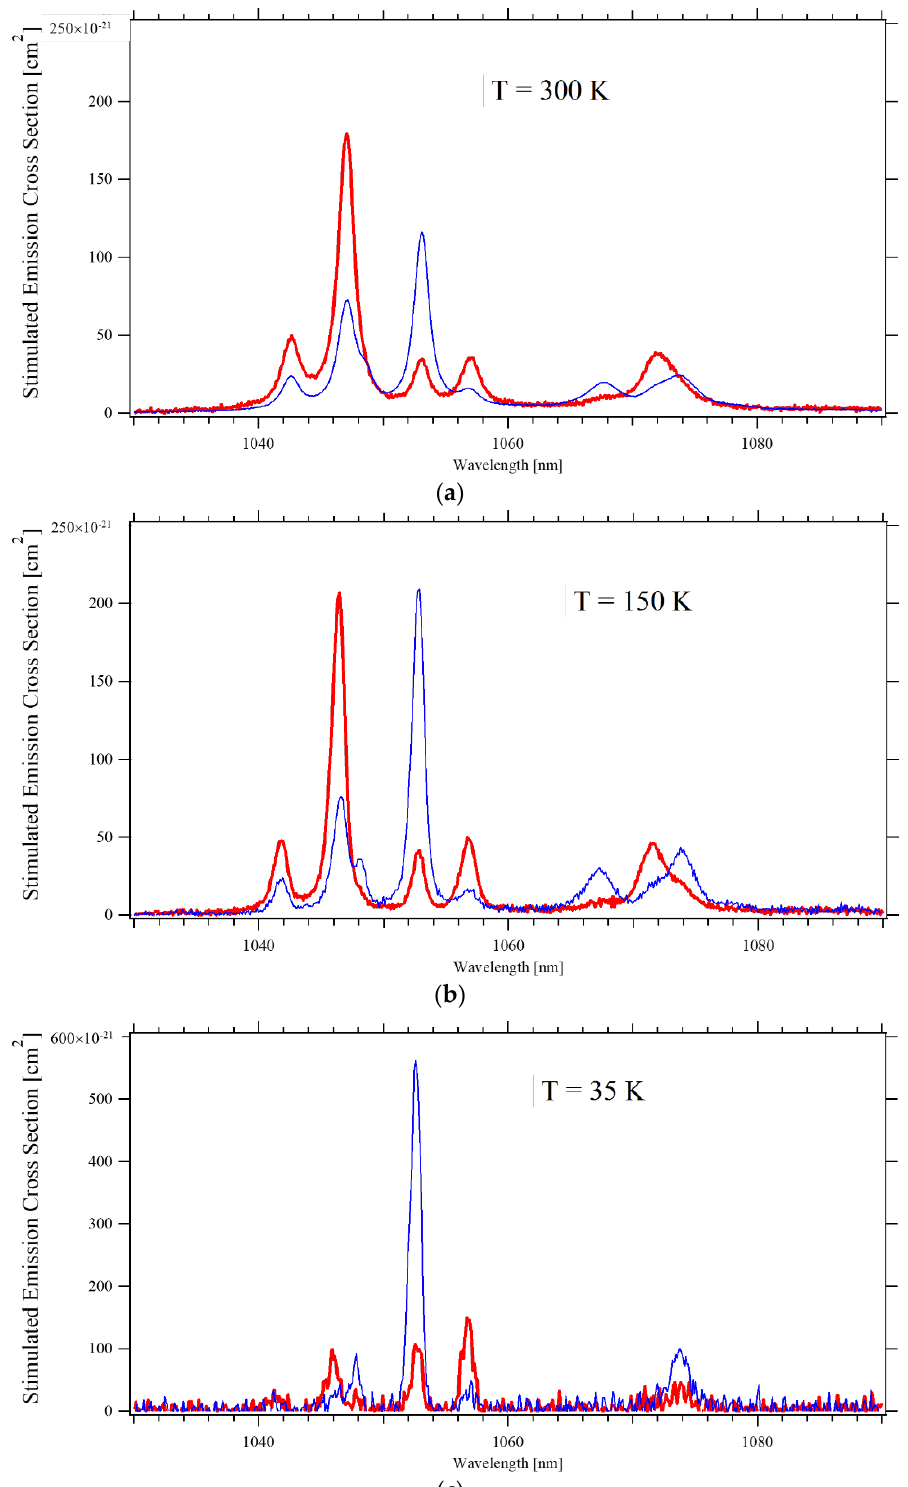
Figure 4. Emission cross-section of the 4 F 3/2 → the 4 I 11/2 transition for π –polarized (Red) and σ –polarized (Blue) light, at three temperatures: ( a ) T = 300 K; ( b ) T = 150 K; ( c ) T = 35 K.